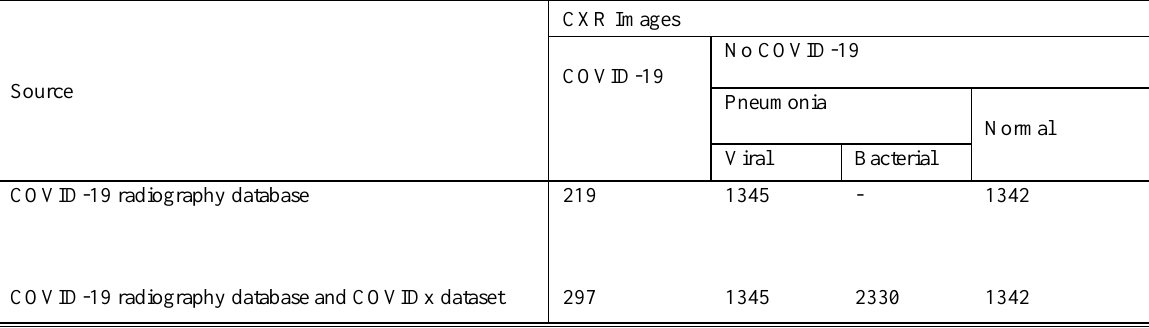
Table 1 . The distribution of CXR images amongst the different infection types.